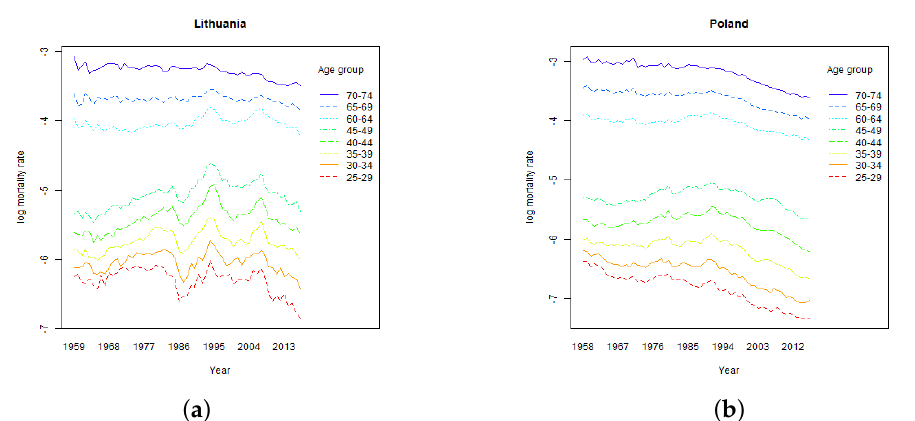
Figure 6. Development of log mortality rates in Lithuania ( a ) and Poland ( b ) according to data from the Human Mortality Database